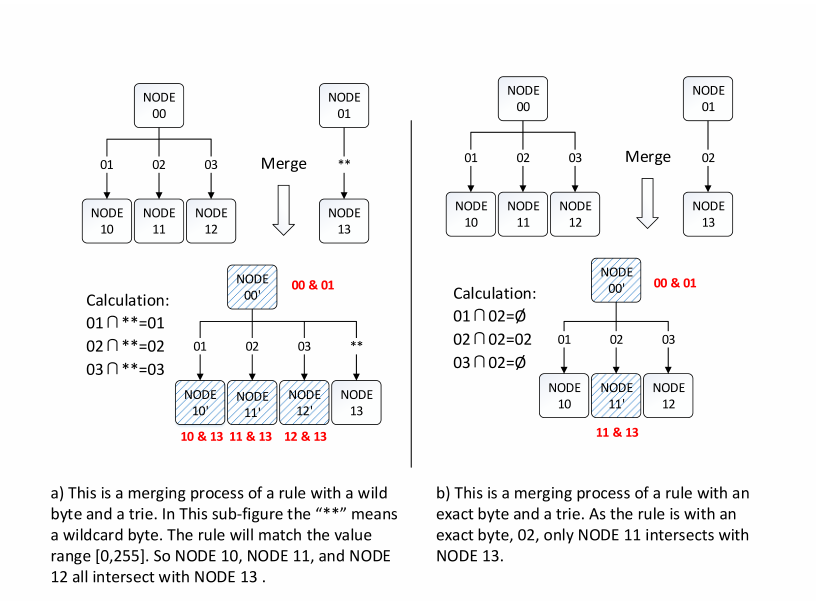
Figure 3. The sample of merging in update